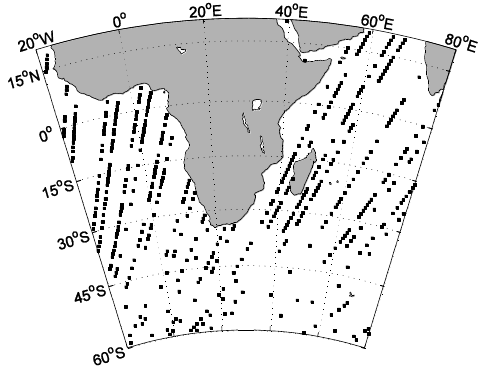
Figure 6 Ascending orbit data image taken by the Jason-1 satellite from 13 to 18 May 2005.